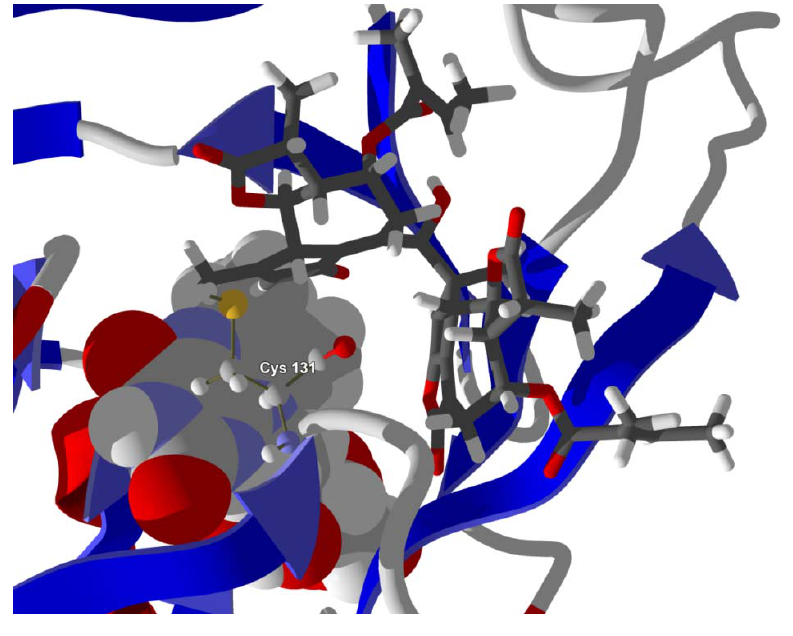
Figure 9. Lowest-energy docked pose of diguaiaperfolin with L. major dihydroorotate dehydrogenase (LmajDHODH, PDB 3mhu). The cofactor, riboflavin monophosphate, is shown as a space-filling